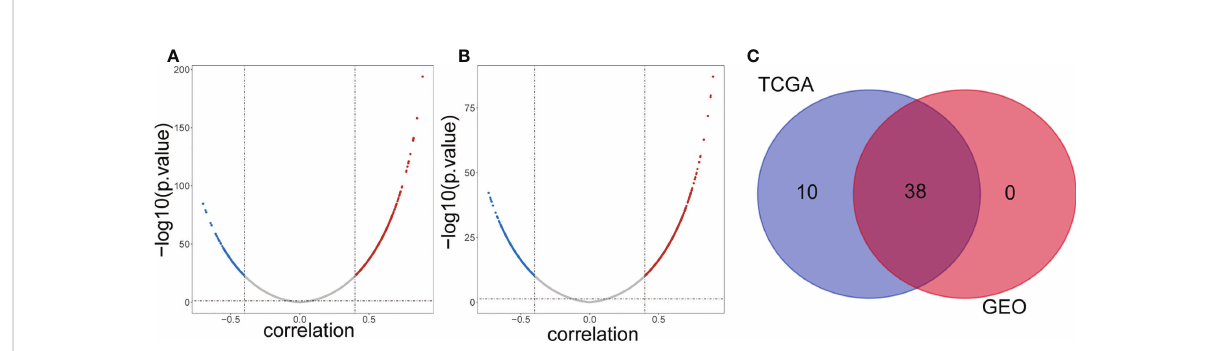
FIGURE 2 Screening lipid metabolism-related differential expressed IncRNAs. (A) Volcano plot of lipid metabolism-related DE-IncRNAs from TCGA dataset. Red and green indicate up-regulated and down-regulated IncRNAs respectively. (B) Volcano plot of lipid metabolism-related DE-IncRNAs from GEO dataset. Red and green indicate up-regulated and down-regulated IncRNAs respectively. (C) Venn diagram of the intersection of lipid metabolism-related